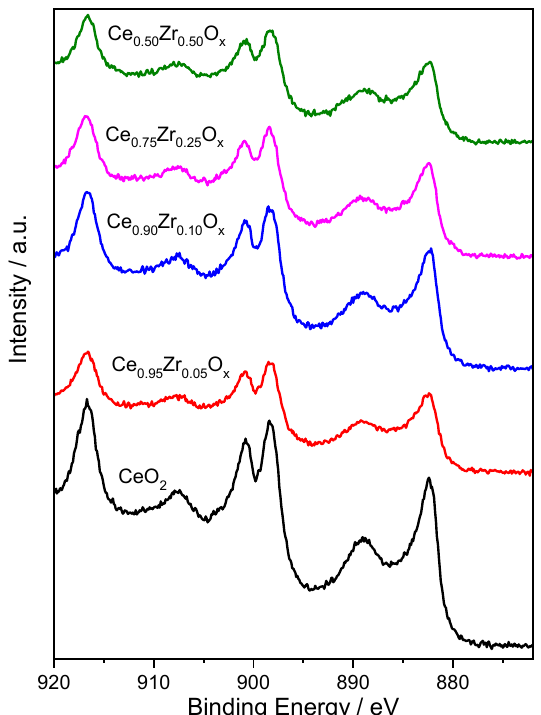
Figure 7. XPS spectra of the Ce 3d peaks for the ceria–zirconia mixed metal oxide catalysts prepared from carbonate precursors.